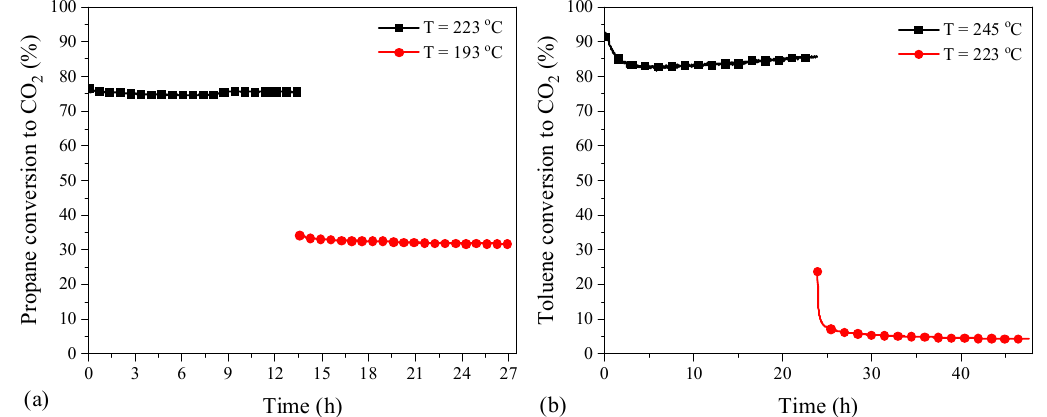
Figure 11. The influence of time on stream ( a ) propane and ( b ) toluene oxidation over the most active catalysts (cooling ramp).